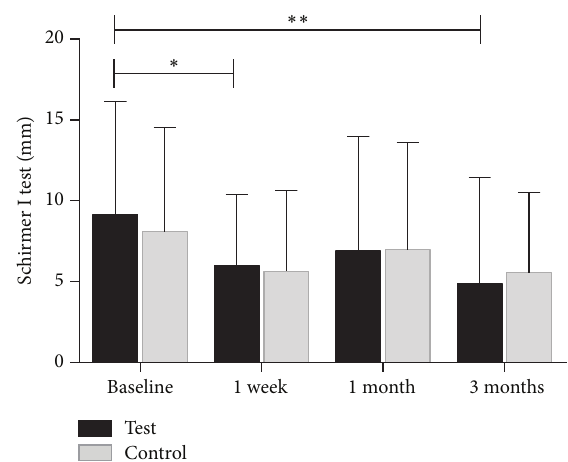
Figure 7: The mean value of test-eye Schirmer I test without anesthesia measured at baseline, at one week, at one month, and at three months ( ∗ 𝑝 < 0.05 , ∗∗ 𝑝 < 0.001